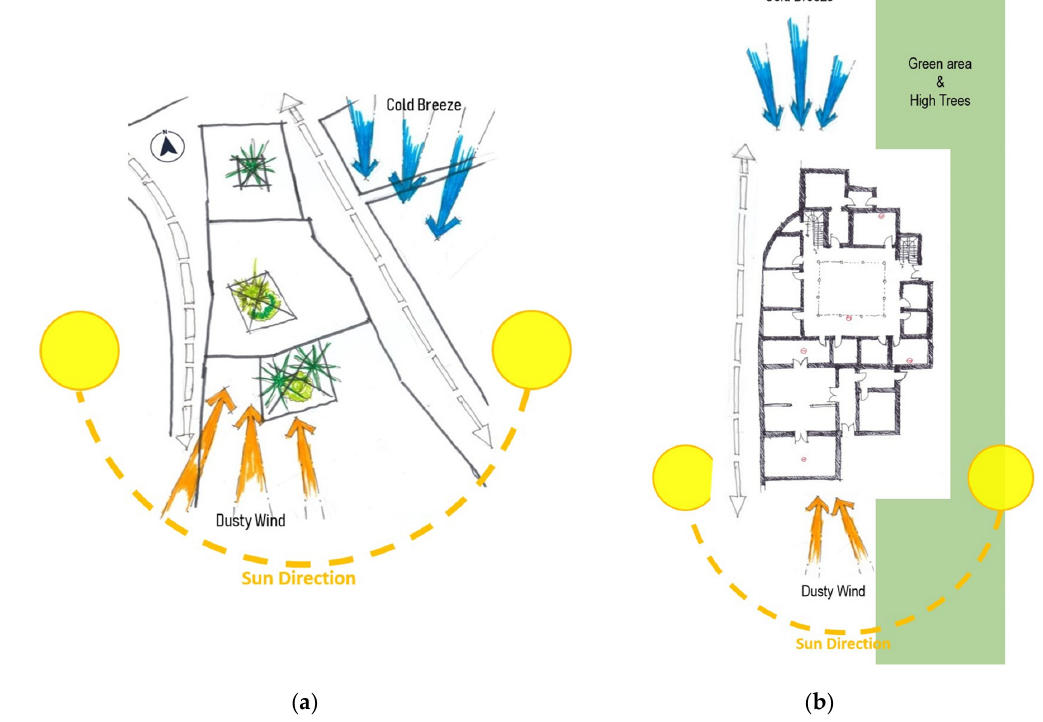
Figure 5: ( a ) site analysis for traditional building in Riyadh city, KSA; and ( b ) site analysis for traditional building in Hail city, KSA.